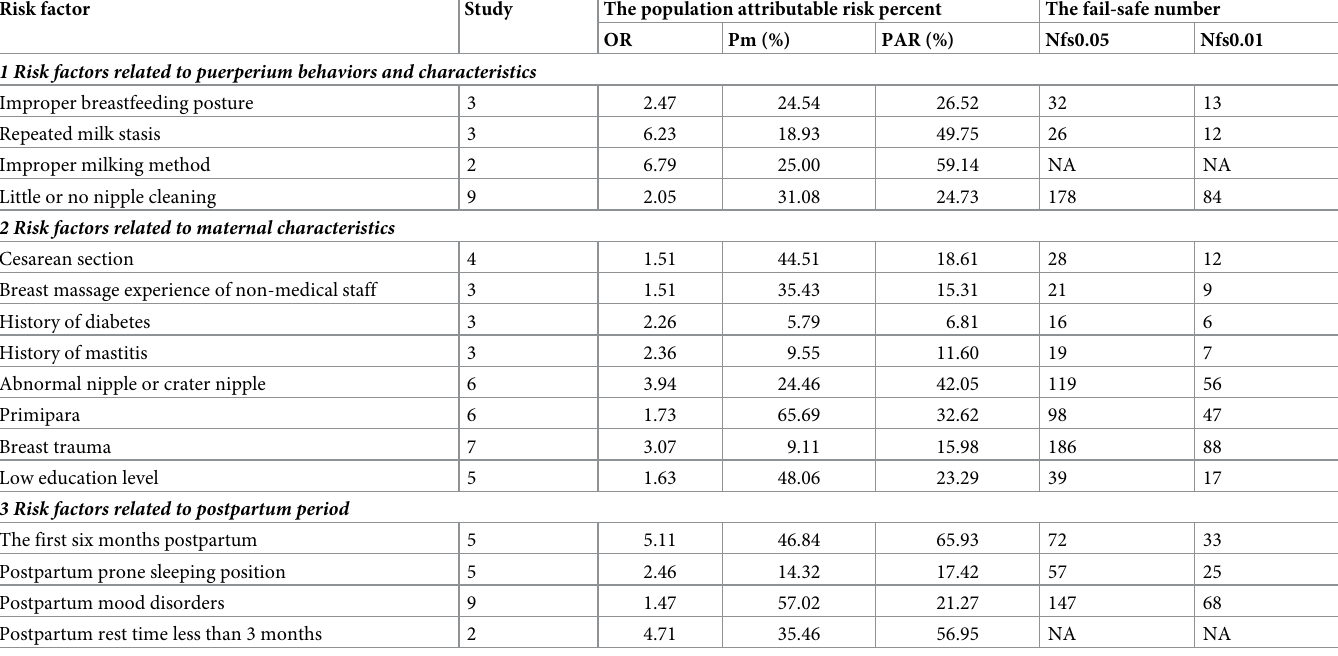
Table 2. The results of the PAR and the Nfs for risk factors associated with LM. Risk